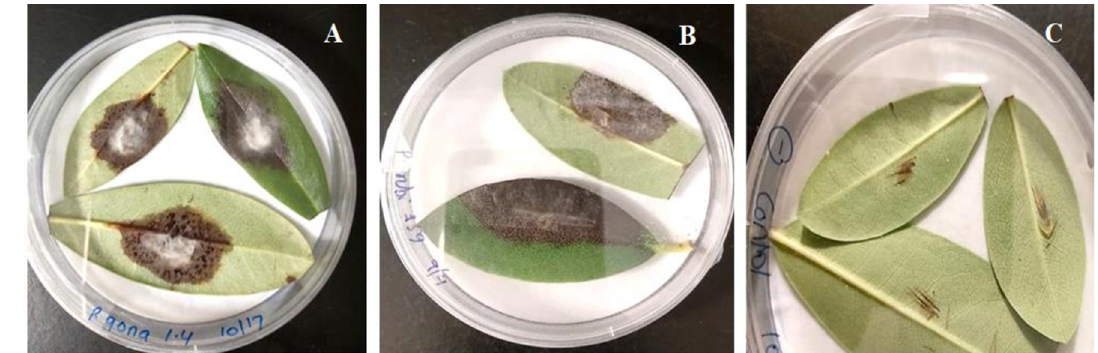
Fig 7. Dark lesions produced on rhododendron leaves by isolates of P . gonapodyides (A), P . rubi (B). Lesions did not develop in non- inoculated control leaves (C).